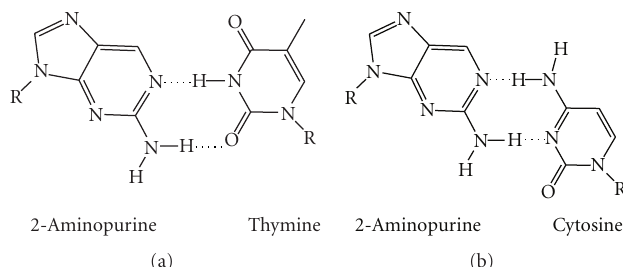
Figure 10: 2-Aminopurine (2AP) and its base pairs (a) 2AP base paired with thymine and (b) 2AP base paired with cytosine [124].